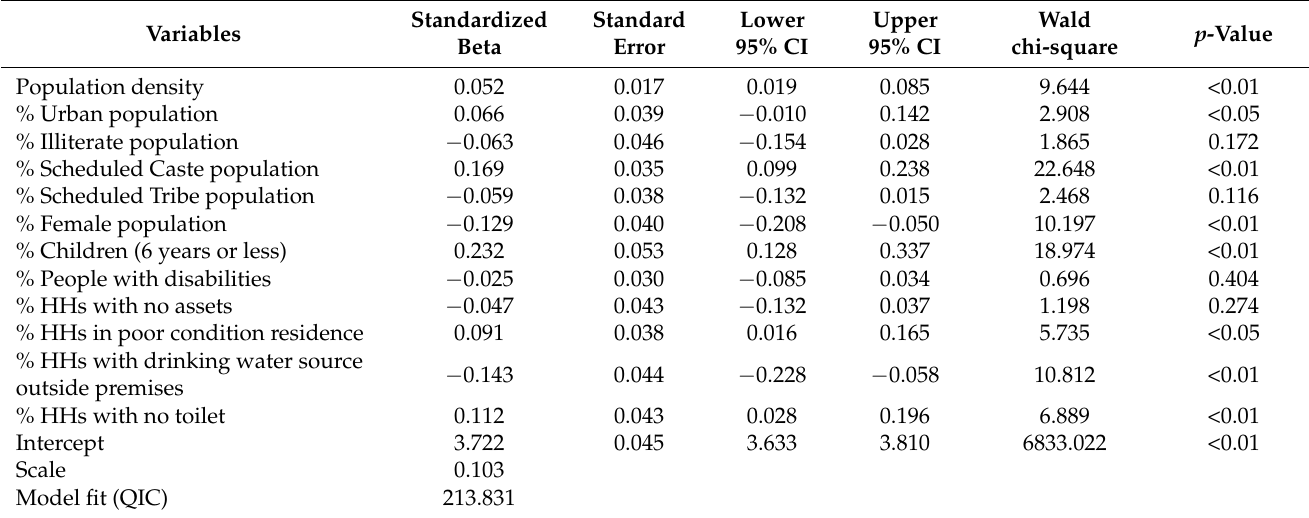
Table 4. Generalized Estimating Equation (GEE) for predicting average PM 2.5 concentration in 2010 ( N = 640).